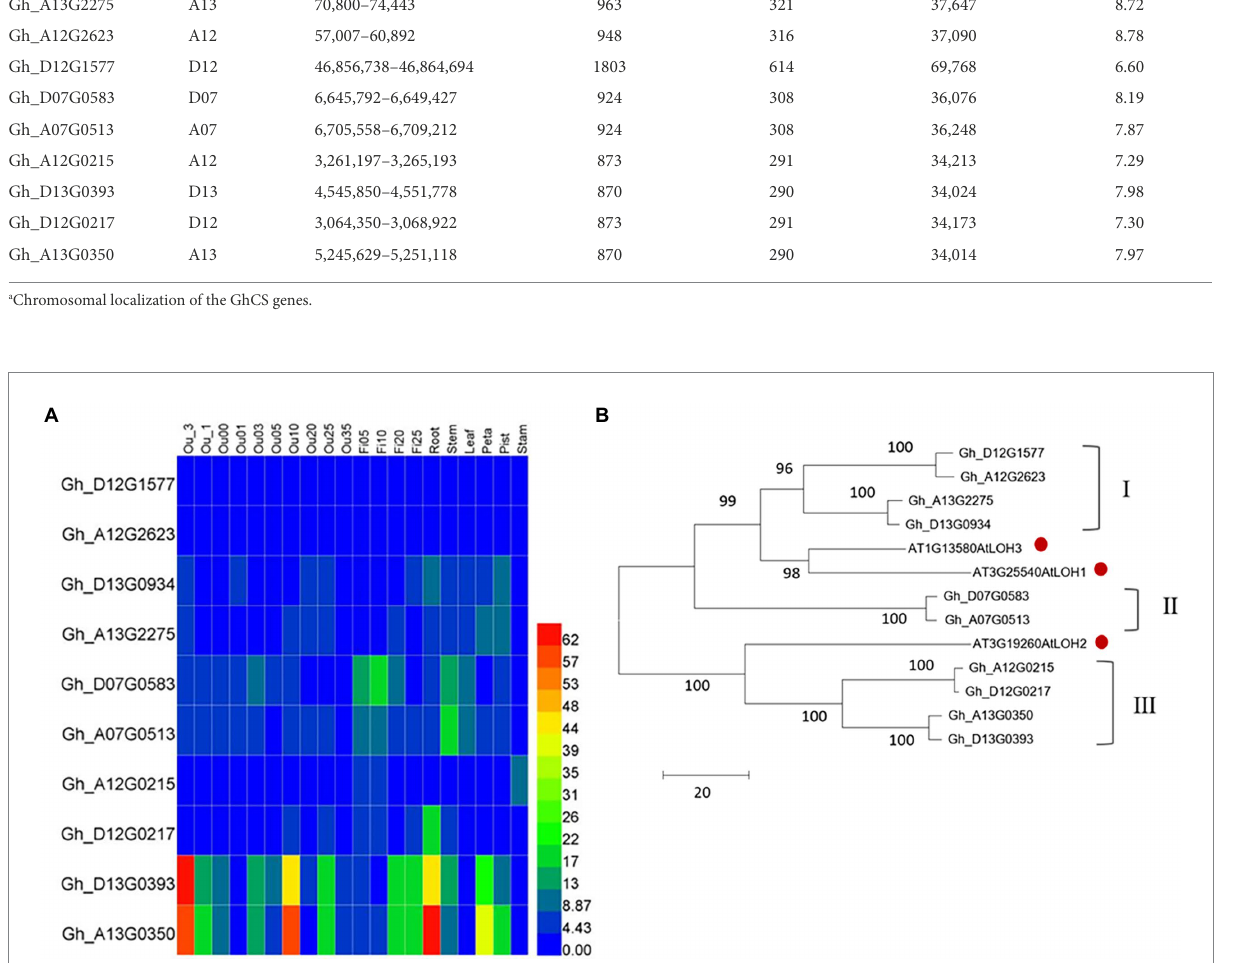
FIGURE 1 Characters of upland cotton GhCS genes. (A) The expression pattern of genes encoding ceramide synthase in upland cotton. (B) The phylogenetic relationship of cotton ceramide synthase with Arabidopsis thaliana homologs. The red dot indicated the Arabidopsis ceramide synthase. Ou_1 and Ou_3: the ovule of 1 and 3 days (s) before anthesis; Ou00: the ovule (with fiber cells) on the day of anthesis; Ou01 and Ou3: the ovule (with fiber cells) of 1 and 3 days (s) post anthesis, respectively; Fi05 to Fi25: the fiber cells of 5 to 25 days post anthesis; Ou05 to Ou35: the ovule (without fiber cells) of 5 to 35 day (s) post